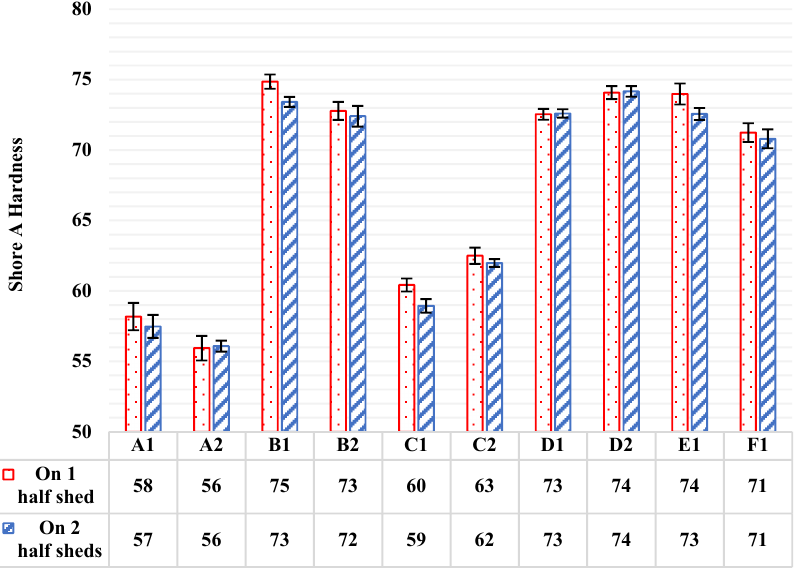
Figure 5. Average values (columns) and standard deviations (error bars) of shore A hardness measurements on one half shed and on two half sheds, made of HTV silicone rubber with ATH filler, of all available composite insulators.